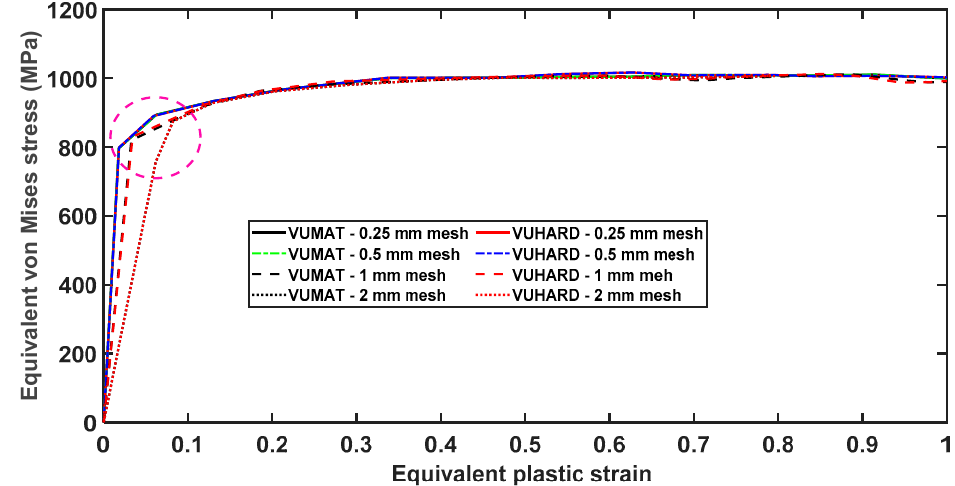
Figure 19. The numerical equivalent von Mises stresses against equivalent plastic strains at a temperature of 298 K and imposed velocity of 4 m/s for different mesh densities obtained from the VUMAT and VUHARD subroutines developed here.